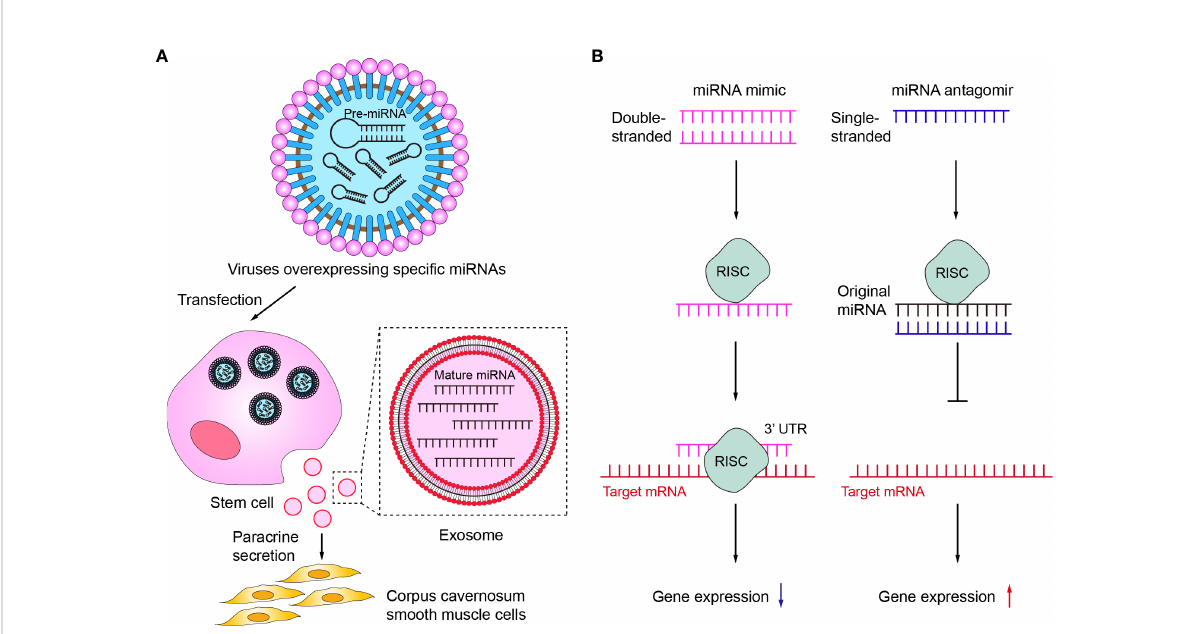
FIGURE 4 Therapeutic potentials of miRNA in ED. (A) Delivery of corresponding miRNAs via stem cells or exosomes. (B) The mechanisms of miRNA mimic and miRNA antagomir. RISC, RNA-induced silencing